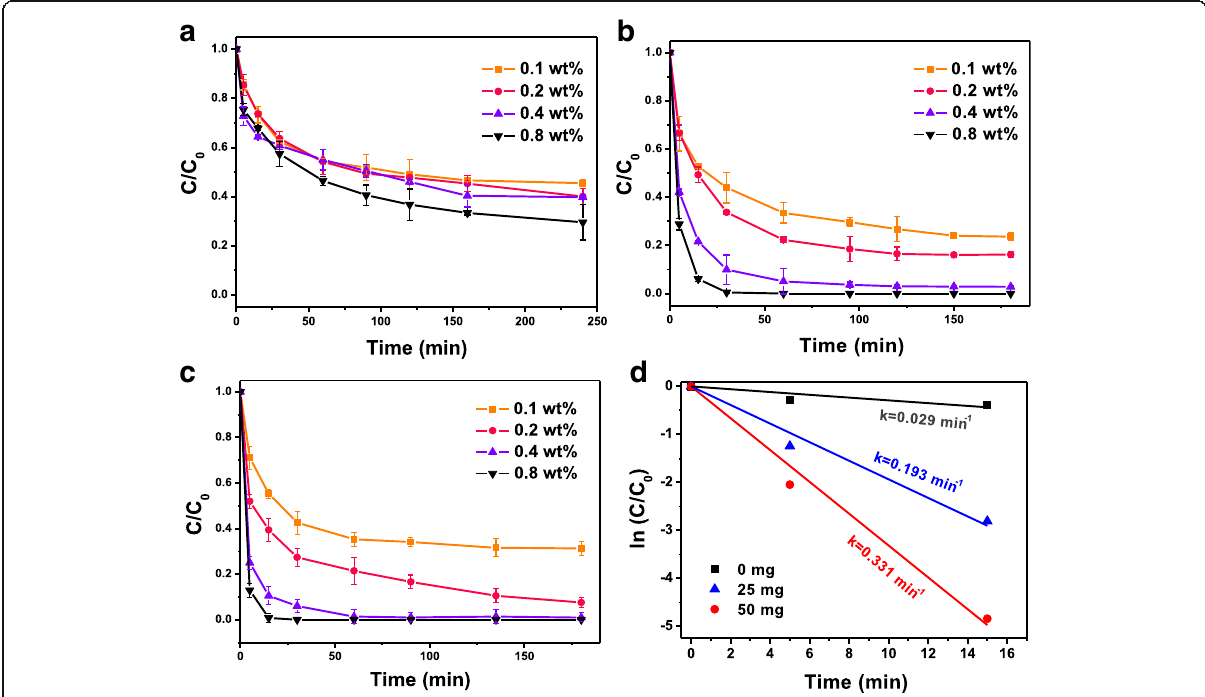
Fig. 3 a – c Time courses of dechlorination using bare Fe-Pd NPs ( a ) and Fe-Pd@PGA NPs ( b , c ) with different PGA loadings ( b 25 mg PGA; c 50 mg PGA) and different Pt loadings ranged from 0.1 to 0.8 wt.%. d The rate constant ( k ) for the dechlorination of p -CP with different PGA